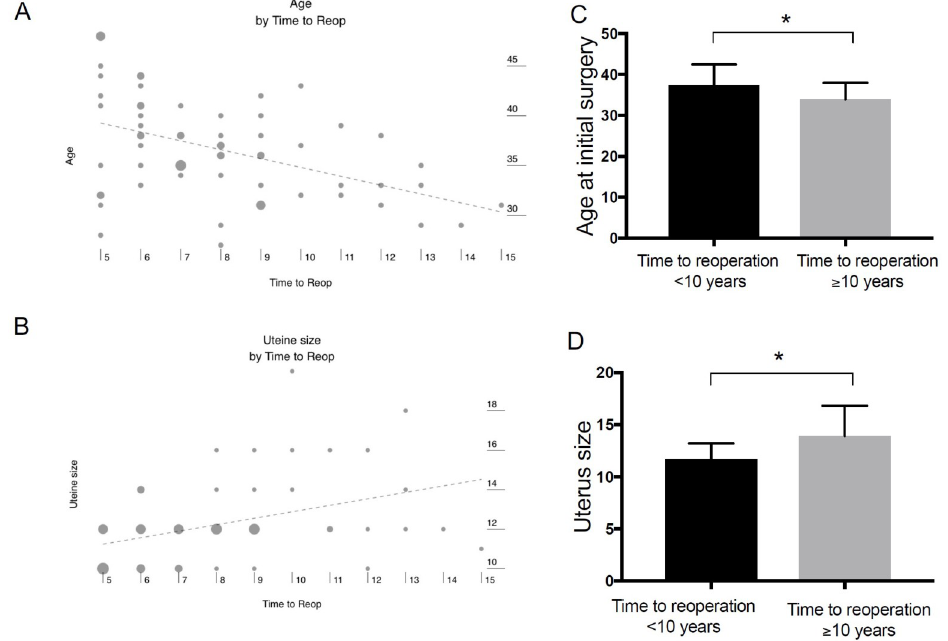
Fig 2. Timing of reoperation. Time between first surgery and patient presenting for repeat uterine surgery was correlated with ( A) age at initial surgery (correlation = -0.46, R2 = 0.21, p < 0.001) and ( B) uterine size at reoperation (correlation = 0.41, R2 = 0.16, p < 0.001). Reoperation a decade or more after initial surgery was significantly correlated with ( C) younger age at the initial surgery( � p < 0.031) and ( D) larger uterus ( � p < 0.008).